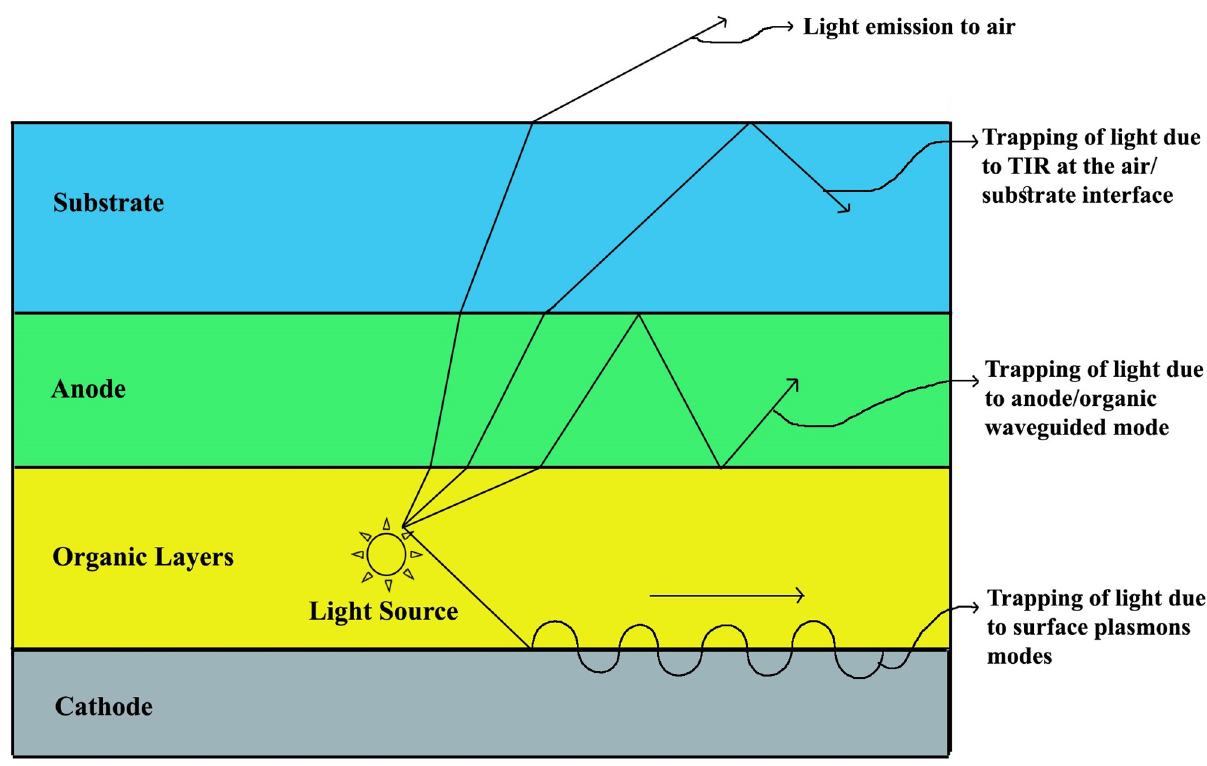
Fig 1. OLED model illustrating trapping of light due to various modes [5].